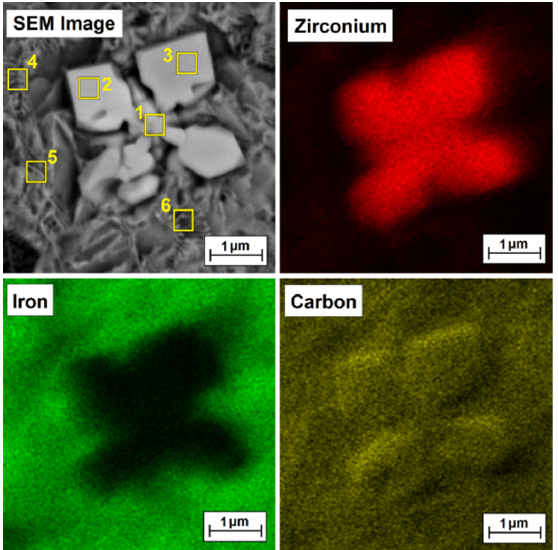
Figure 12. Microstructure and EDS mapping of Fe/ZrC coating produced using a laser beam power of 900 W—middle area of melted zone.